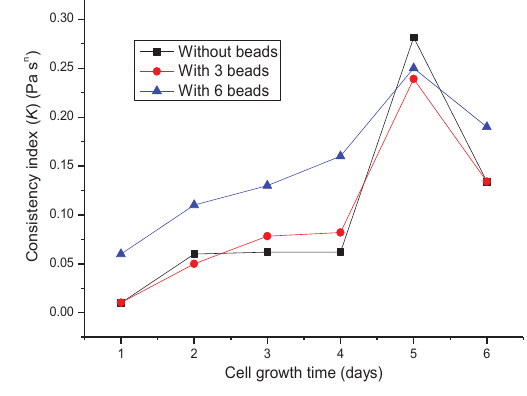
Fig. 6 – Variations in consistency index (K) of the power-law fluid model as cell growth occurs with or without glass